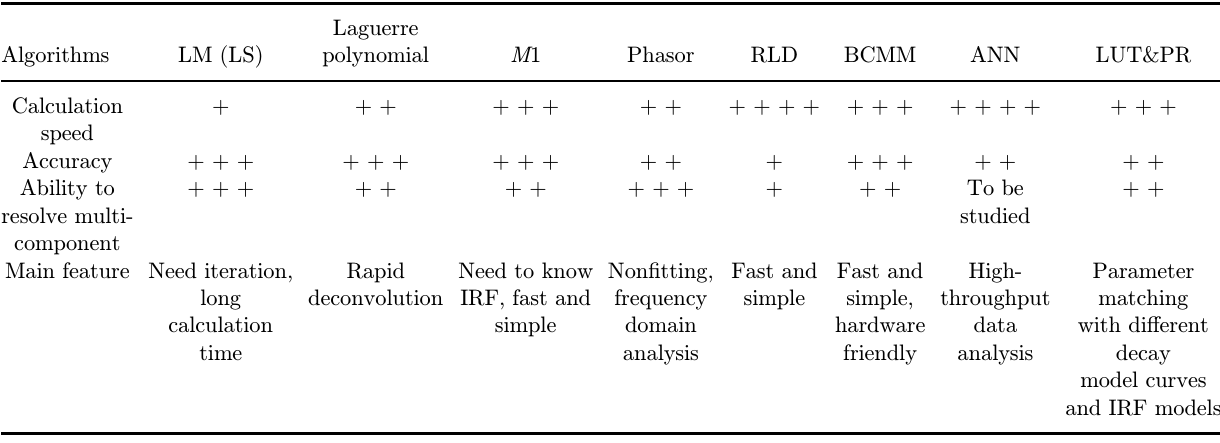
Table 1. Summary of the performance of di®erent algorithms with fast calculation speed. 135 – 154